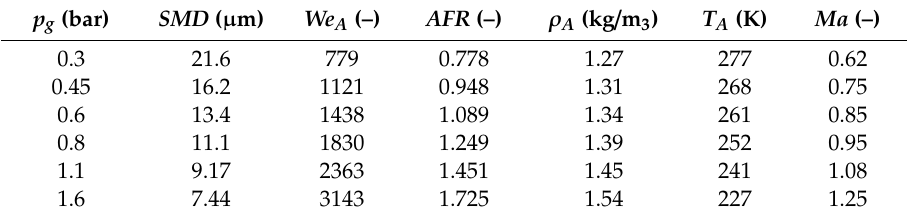
Table 1. Estimated characteristics of atomization at various p g .